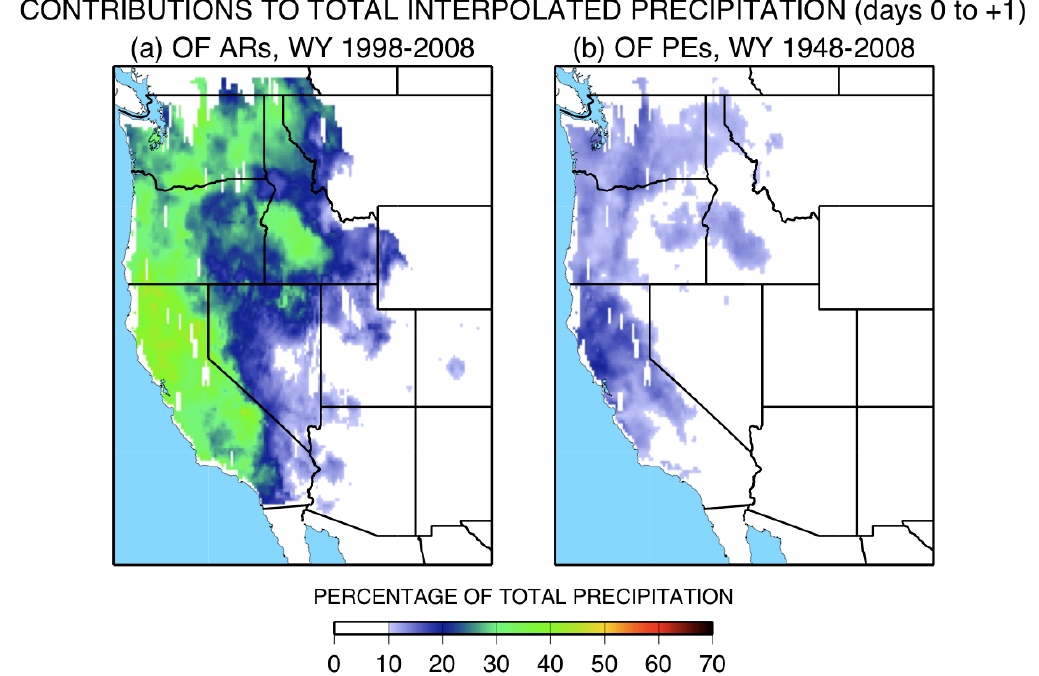
Figure 8. Same as main map in Figure 6, except based on 1/8-degree gridded VIC-input precipitation fields, for (a) AR events and (b) PE